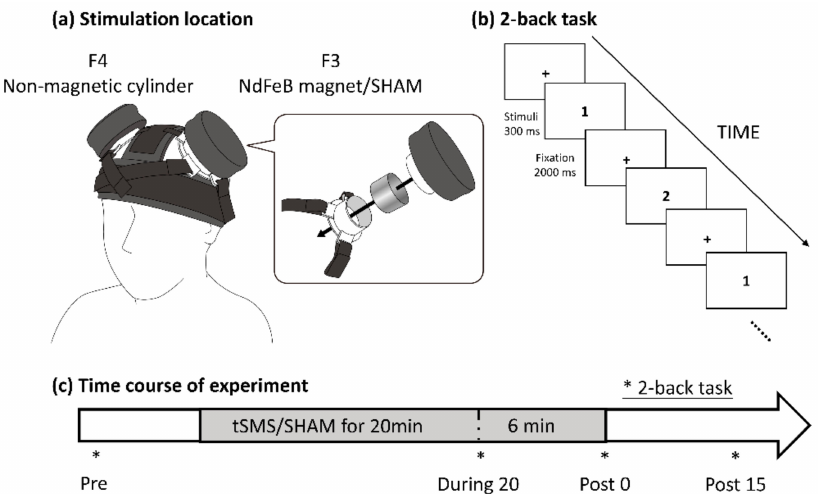
Figure 1. Experimental procedure. The participants received tSMS or SHAM stimulation over the left DLPFC. The magnet or SHAM device was placed on F3, and a non-magnetic cylinder was placed on F4 to counterbalance the weight, using custom-made headgear ( a ). Participants performed the 2-back task ( b ) before (pre), during (during 20), immediately after (post 0), and 15 min after (post 15) tSMS/SHAM stimulation ( c ). The asterisks indicate the time points at which 2-back task was